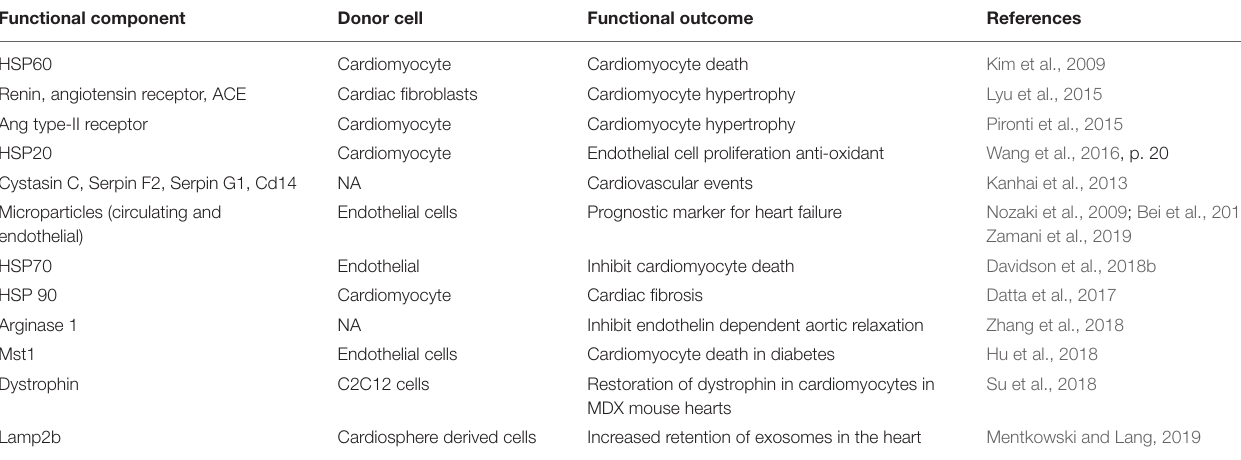
TABLE 4 | Exosome derived proteins in pathophysiology of heart diseases.